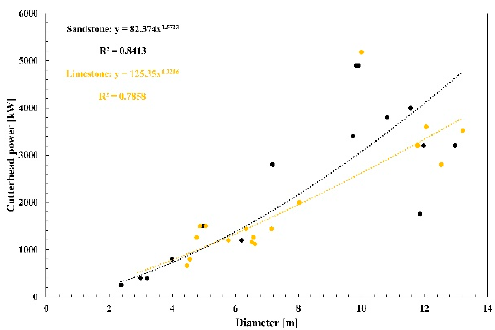
Figure 13. Correlation between the power and the diameter due to the excavation in sandstone and limestone by single shield TBMs.